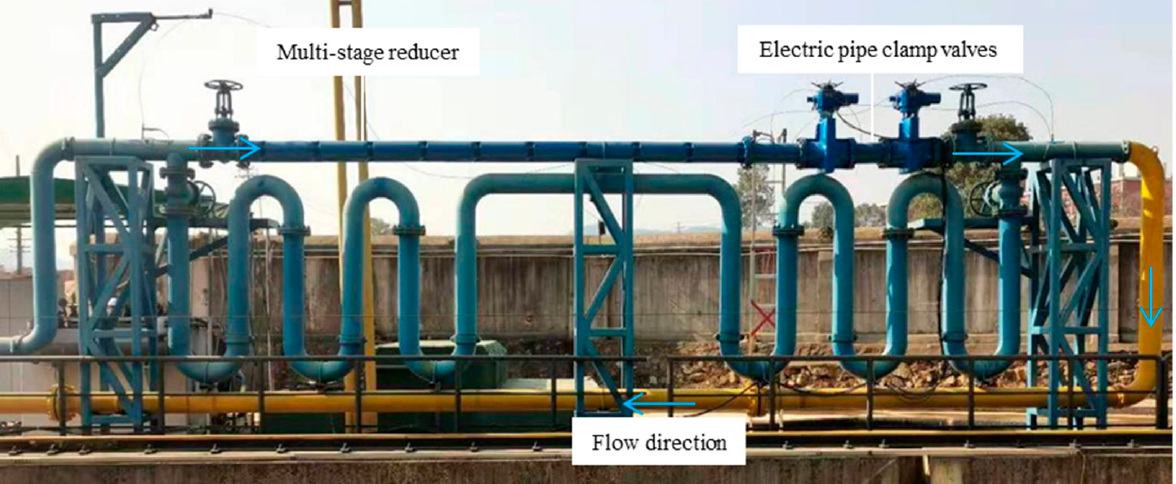
Figure 5. Multi-stage reducer and electric pipe clamp valves.